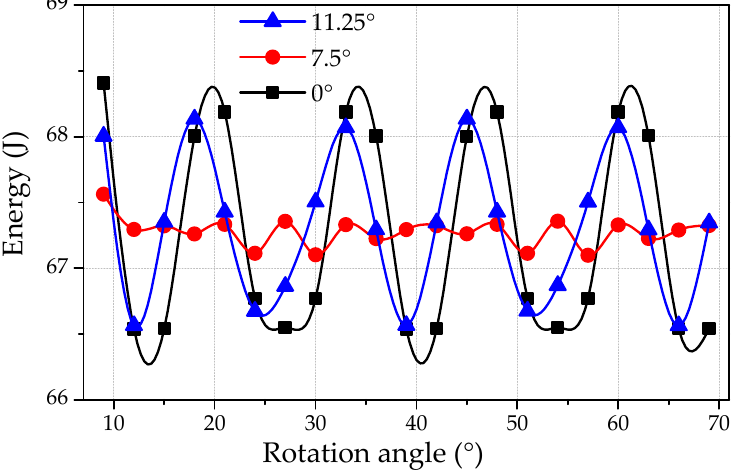
Figure 5. The magnetic field energy vs. the rotating angle for three relative angles between opposite teeth (0°, 7.5°, and 11.25°).